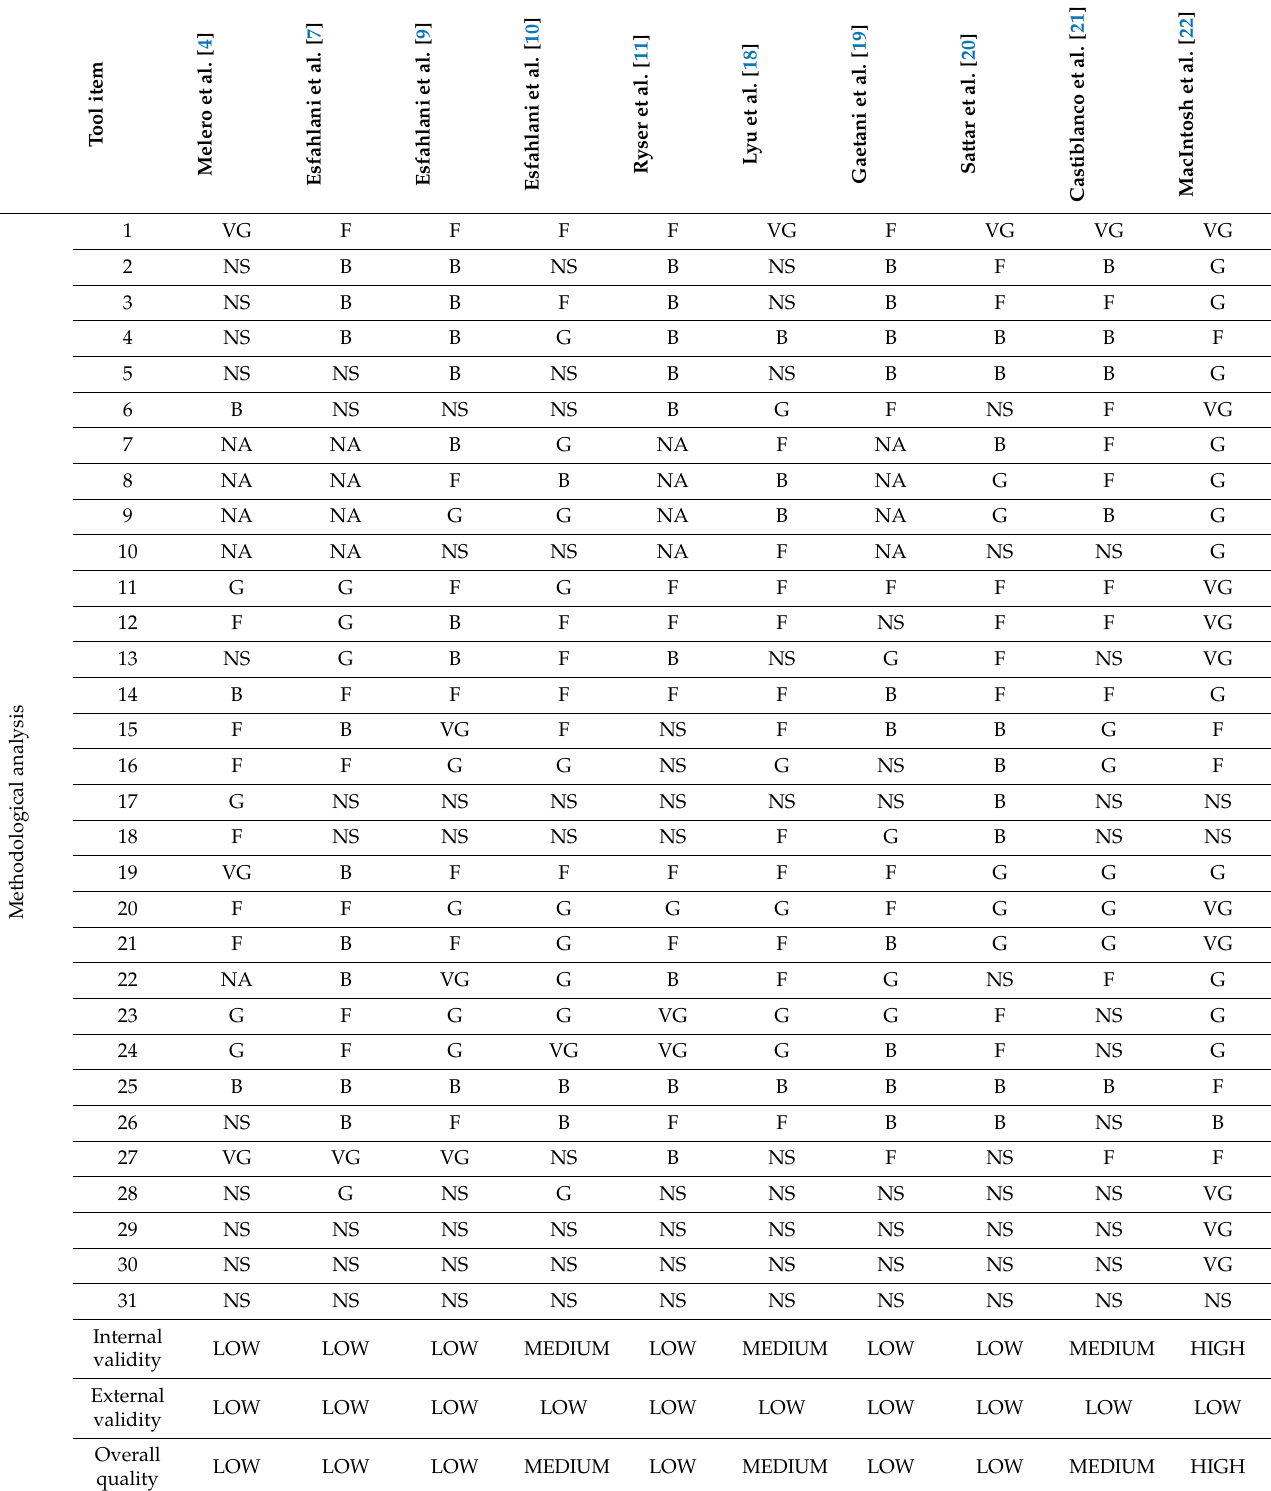
Table 4. Scores for each article after evaluation with the tool for the critical appraisal of epidemiologi- cal cross-sectional studies.